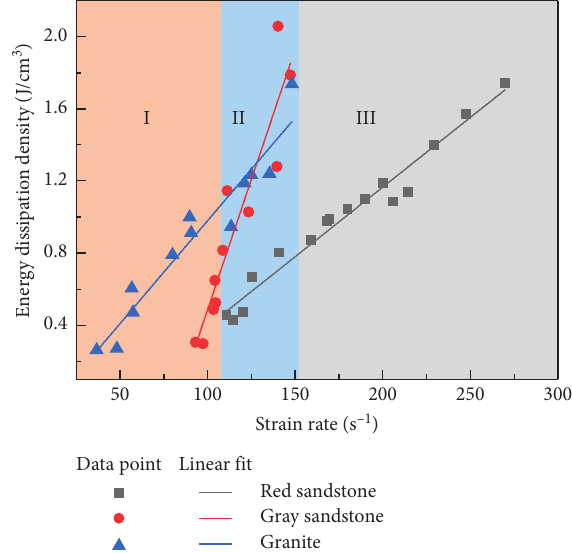
Figure 12: Energy dissipation density-strain rate